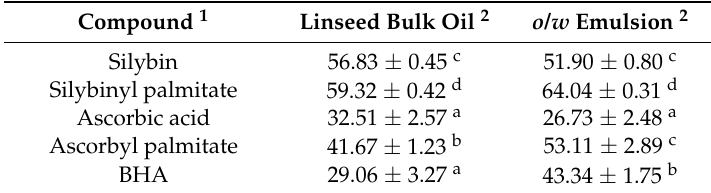
Table 3. Inhibition of conjugated dienes (CD) production in linseed bulk oil and o / w emulsion submitted to accelerated storage during 12